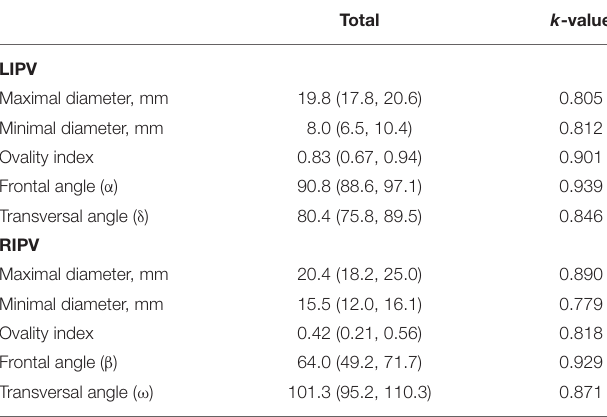
TABLE 4 | Interobserver agreement in anatomical parameters.